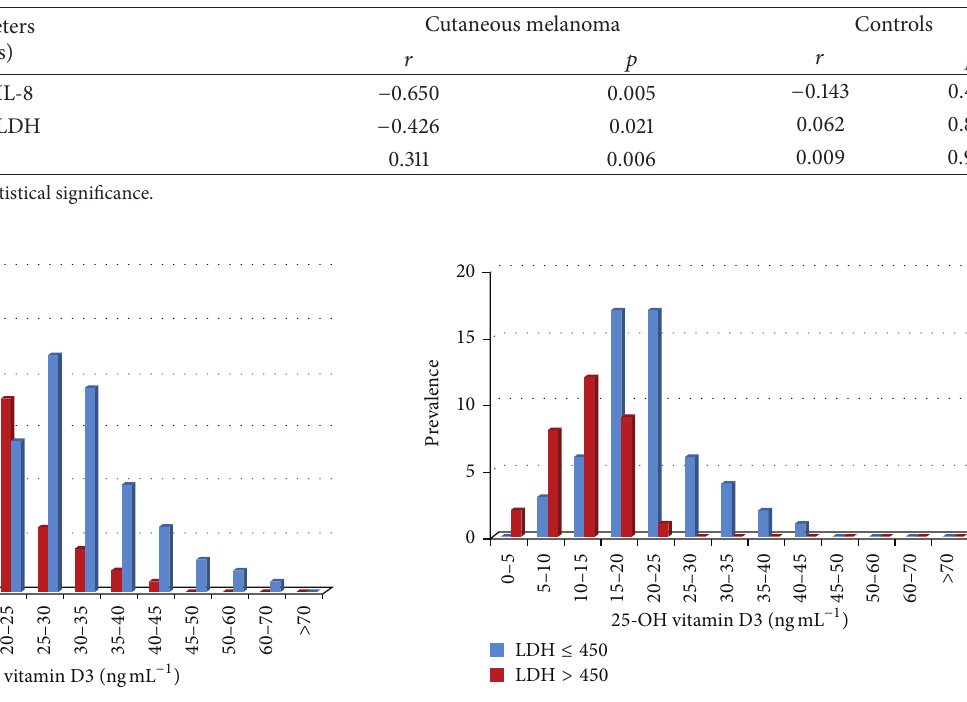
Table 4: Statistical correlations between serum 25-OH vitamin D3, IL-8, and LDH in patients group and controls.